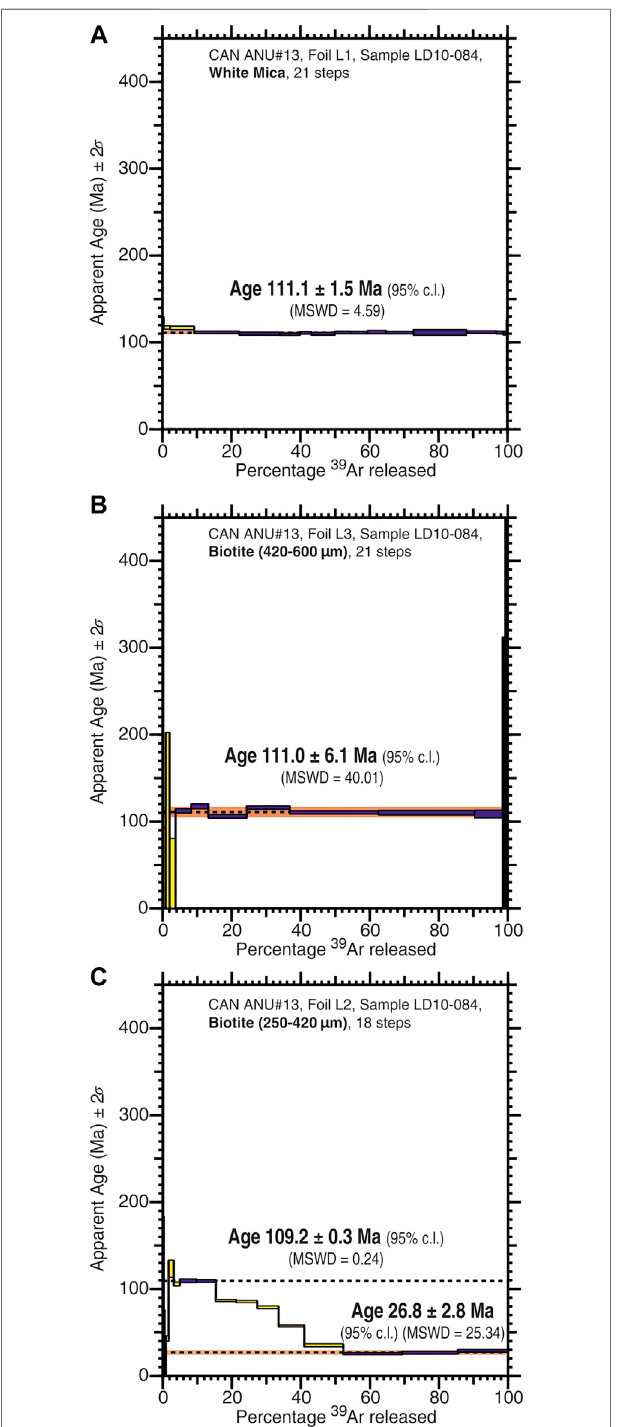
FIGURE 8 | 40 Ar/ 39 Ar plateaus and apparent age calculation for sample LD10-084. (A) L1:whitemica, (B) L3:coarsebiotite, (C) L2: fi ne-grainedbiotite.